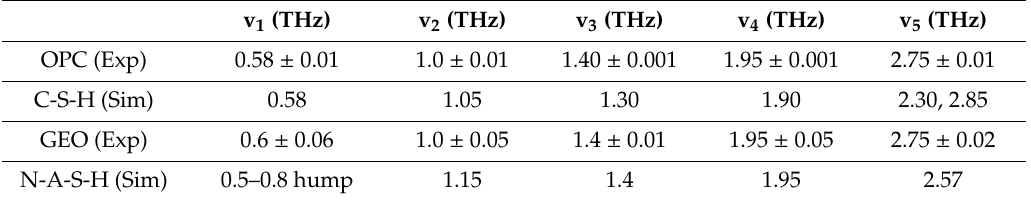
Figure 3. ( a ) Experimental absorbance of the Ordinary Portland Cements (OPC) cement paste, together with the deconvolution of the spectra. ( b ) Computational prediction of the absorbance for the C-S-H model. In the inset the Vibrational Density of States (VDOS) and their projections are displayed. Table 3. Experimental THz frequencies of the main peaks detected in transmission experiments over OPC and geopolymer cement pastes along with the values predicted for C-S-H and N-A-S-H models by atomistic simulations. The uncertainties for the peaks of the fitting scheme have been estimated according to the method explained in Appendix A, while those of the simulations are below the used damping parameter (0.15